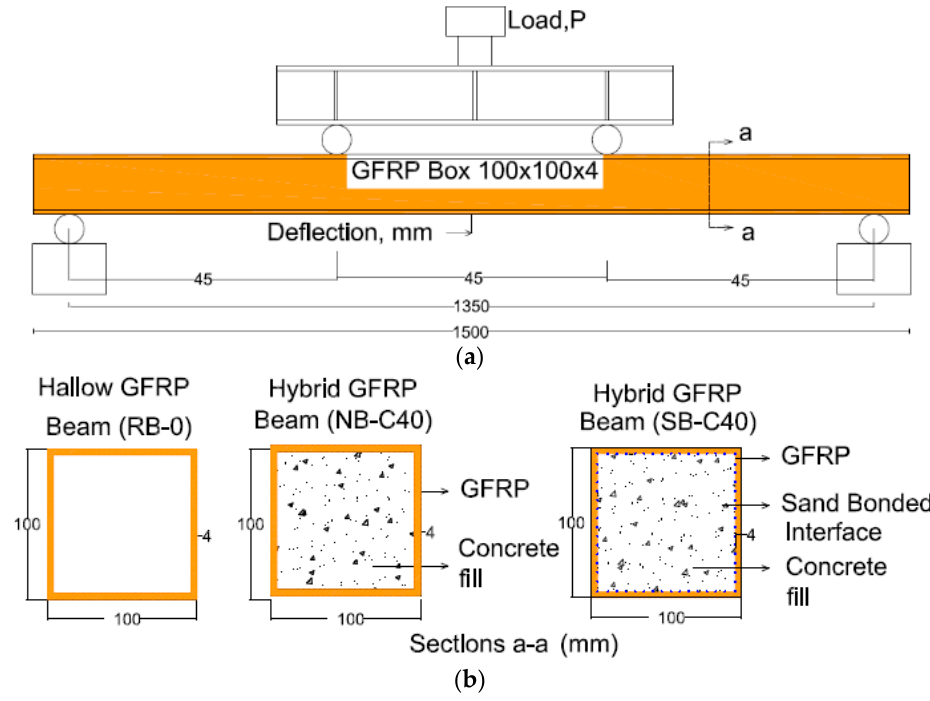
Figure 2. ( a ) Four-point test configuration of the GFRP beams; ( b ) Cross sections with reference, RB-0, natural, NB-C40, and sanded surfaces, SB-C40.